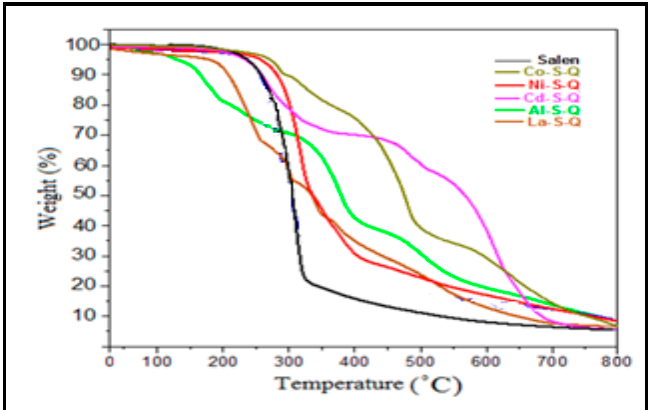
Figure 7. TGA curves for thermal degradation of salen/8-hydroxyquinoline ligand and its Co(II), Ni(II), Cd(II), Al(III), and La(III) metal complexes from ambient temperature to 800 °C at a heating rate of 10 °C/min.